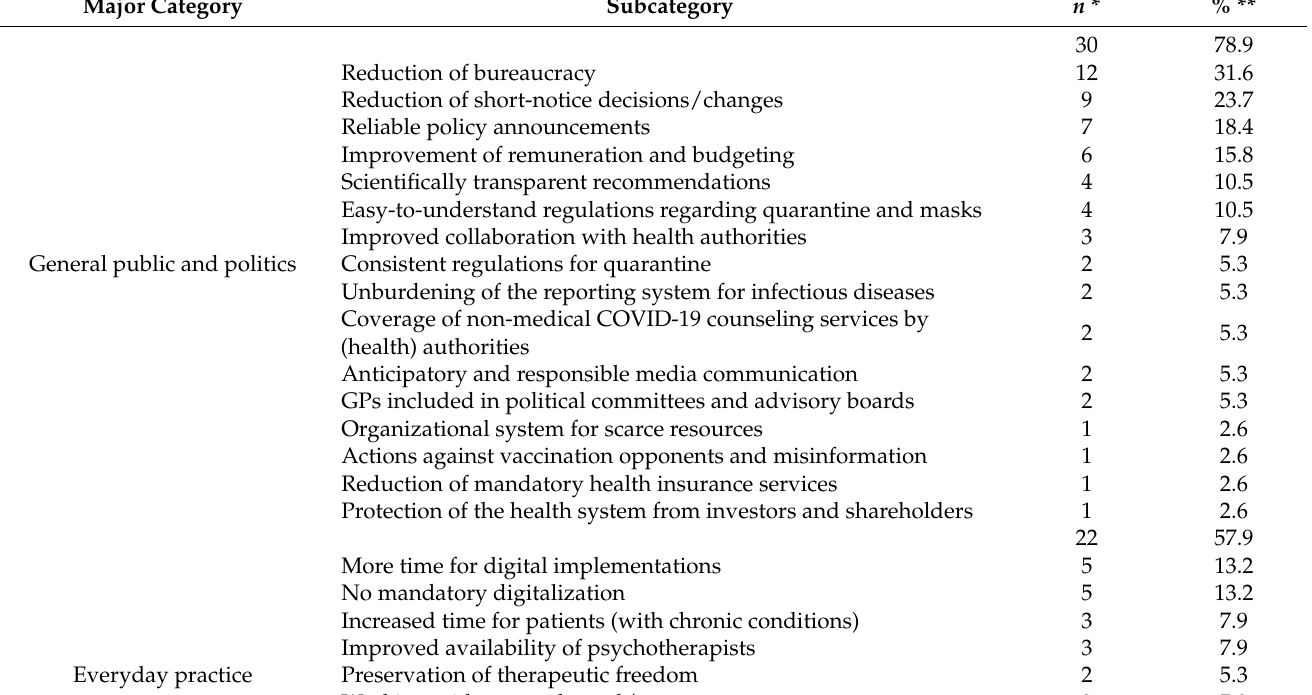
Table 5. GPs’ wishes for improvements ( n = 38) at follow-up 2022: content analysis of free text answers. Major